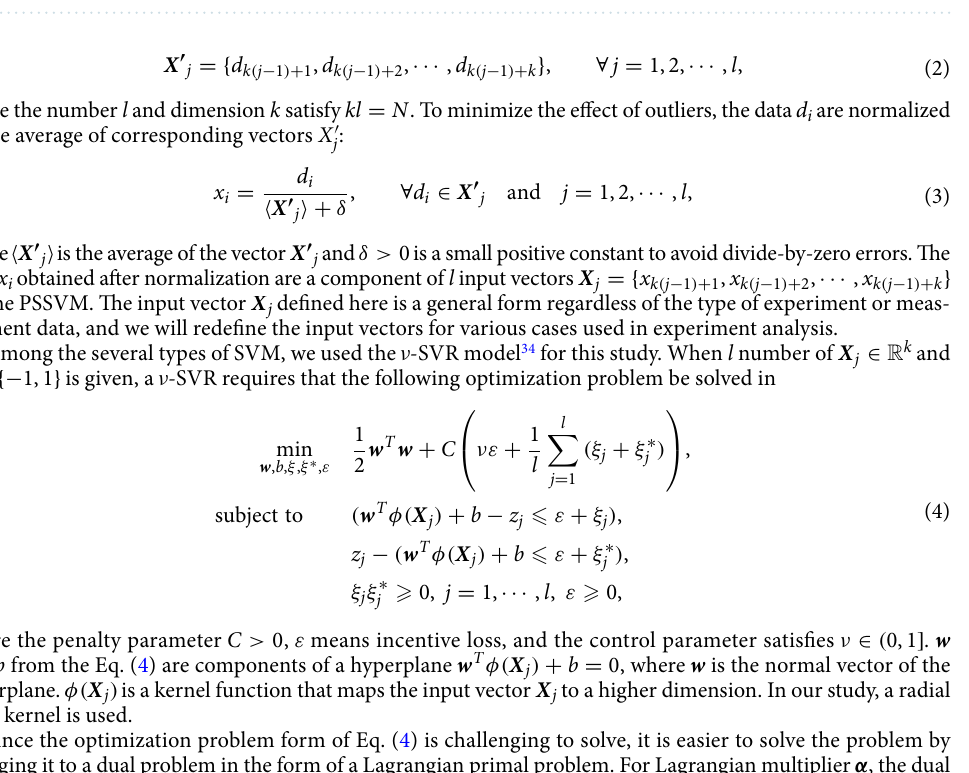
Figure 1. Photon count statistics from the heralded photon-pair generation experiment. Each experiment was performed twice, with and without the background photon noise. ( a ) Signal photons and ( b ) photon- pair coincidence were counted. 10,000 data were collected for each training case with a photon counting time interval of 25 ms. ( c ) The statistics of signal photons is fit to the mmBE distribution and ( d ) the coincidence statistics of photon-pairs is fit to a Poisson